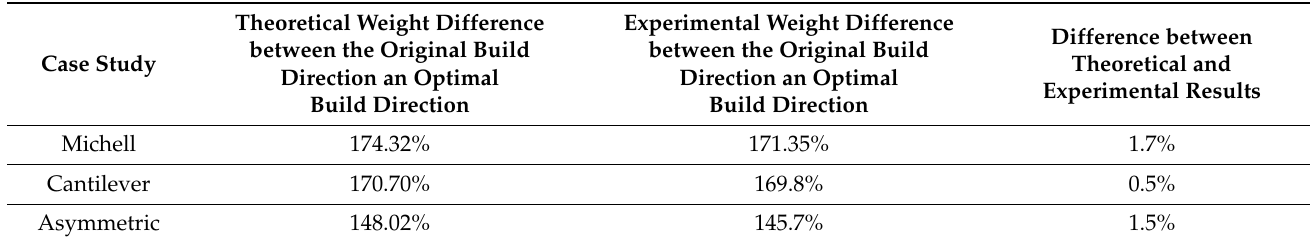
Table 3. Comparing the experimental results with the maximum and minimum RSV calculated using the developed methodology.